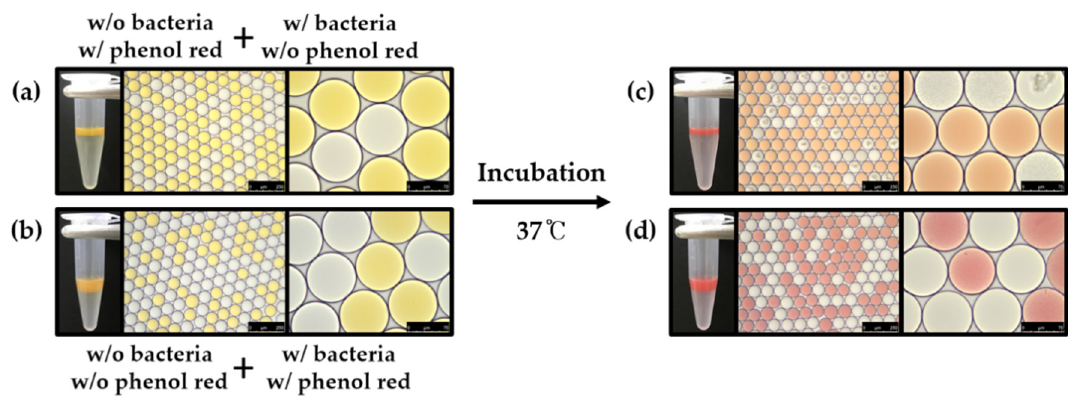
Figure 9. Identification of crosstalk components through droplet barrier. ( a ) Droplet mixture of phenol red-containing droplets with E. coli K-12-containing droplets. ( b ) Droplet mixture of empty droplets with co-encapsulated droplets (both phenol red and E. coli K-12). Droplet mixtures were imaged before ( a , b ) and after ( c , d ) overnight incubation. (scale bar of left panels = 250 µ m, scale bar of right panels = 75 μ m).